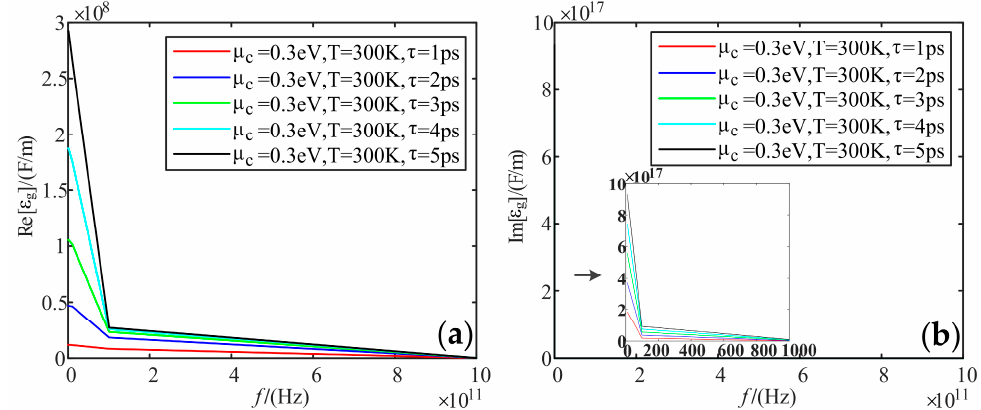
11 of 21 Figure 8. Variation curve of graphene dielectric constant with frequency at different temperatures: ( a ) real part; ( b ) imaginary part. Fixing electrochemical potential is 0.3 eV, and the temperature is 300 K; we analyzed the variation of the real and imaginary parts of the dielectric constant of graphene with frequency, when the relaxation time was taken as 1 ps, 2 ps, 3 ps, 4 ps, and 5 ps.